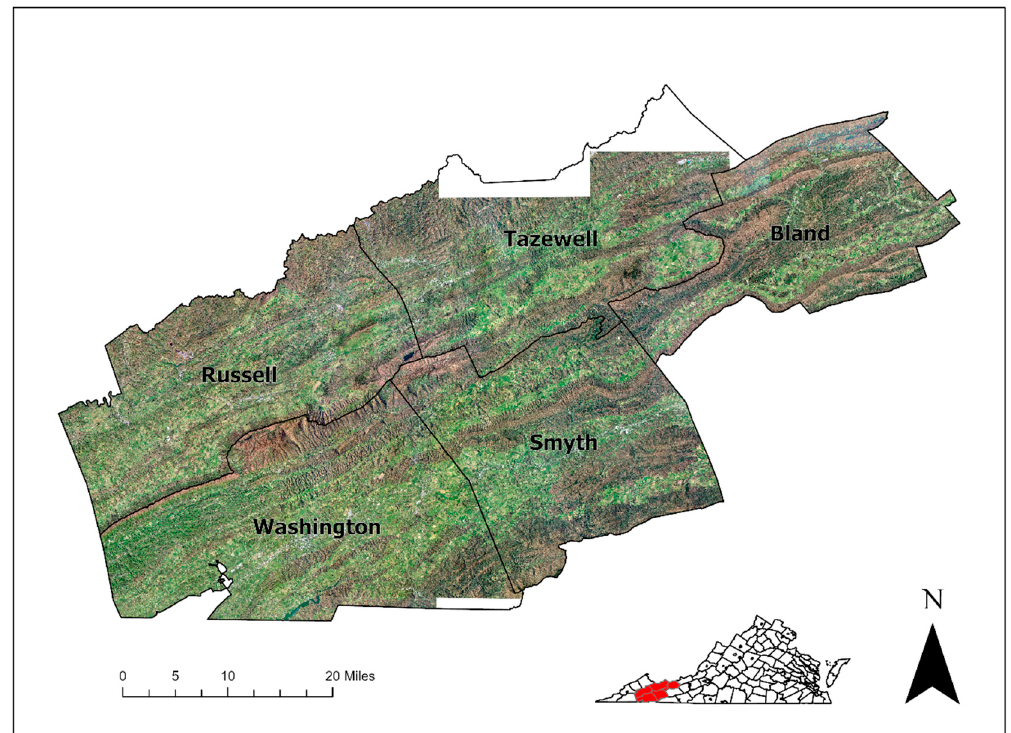
Figure 1. NAIP imagery from the five-county focal region in southwestern Virginia, USA collected in April 2016. The brown areas show forested ridges and the green areas primarily show agricul- ture/grasslands. White areas indicate regions where imagery was collected in a different season (October/November) that were excluded prior to classification. Red shading in lower inset indicates location within the state of Virginia, USA.